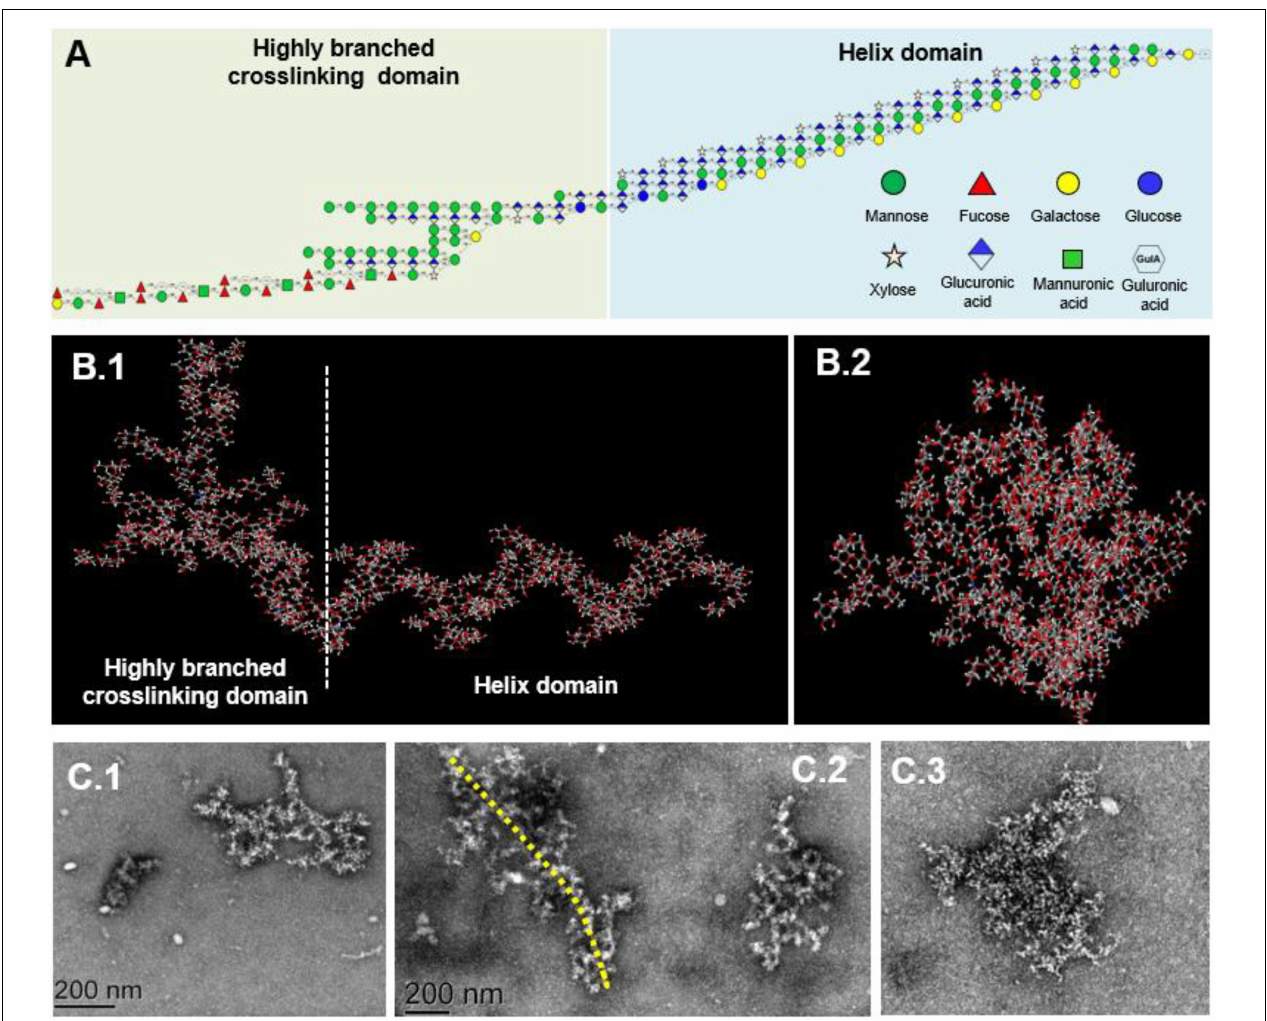
FIGURE 5 | The proposed repeating units and molecular conformation of LJPS. (A) Structural formula, linkage of monomers, and proposed repeating units of LJPS. (B1,B2) Speculated 3-D molecular structure of LJPS from the side (B1) or front (B2) images by the Creators of GLYCAM-Web (http://glycam.org/). (C1–C3) Scanning images of LJPS dissolved in sodium dodecyl sulfate (SDS) and maintained with a dispersed status via transmission electron microscopy